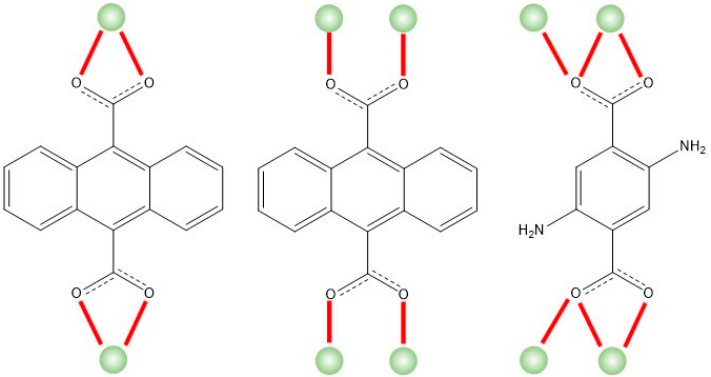
Scheme 1. Different coordination modes shown by the ligands employed to construct metal–or- ganic frameworks